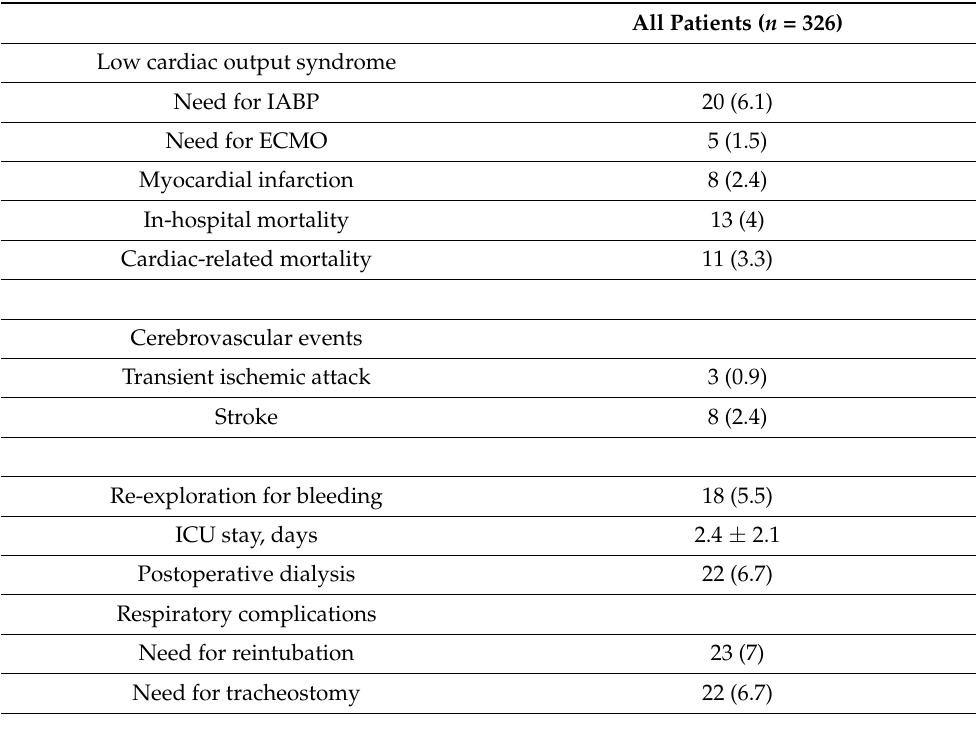
Table 3. Postoperative